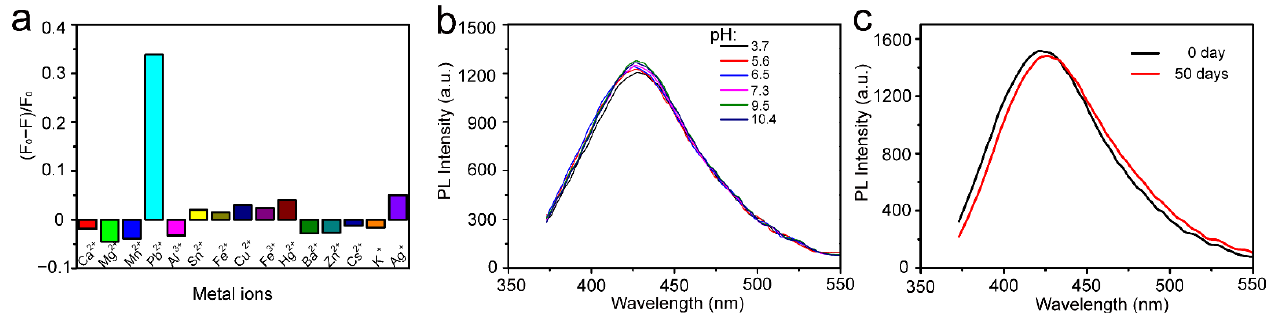
Figure 3. ( a ) The fluorescence enhancement or quenching of MoS 2 QDs in the presence of various metal ions. ( b ) Photoluminescence spectra of MoS 2 QDs under different pH conditions. ( c ) Photoluminescence spectra of MoS 2 QDs stored at 4 °C for 0 and 50 days.